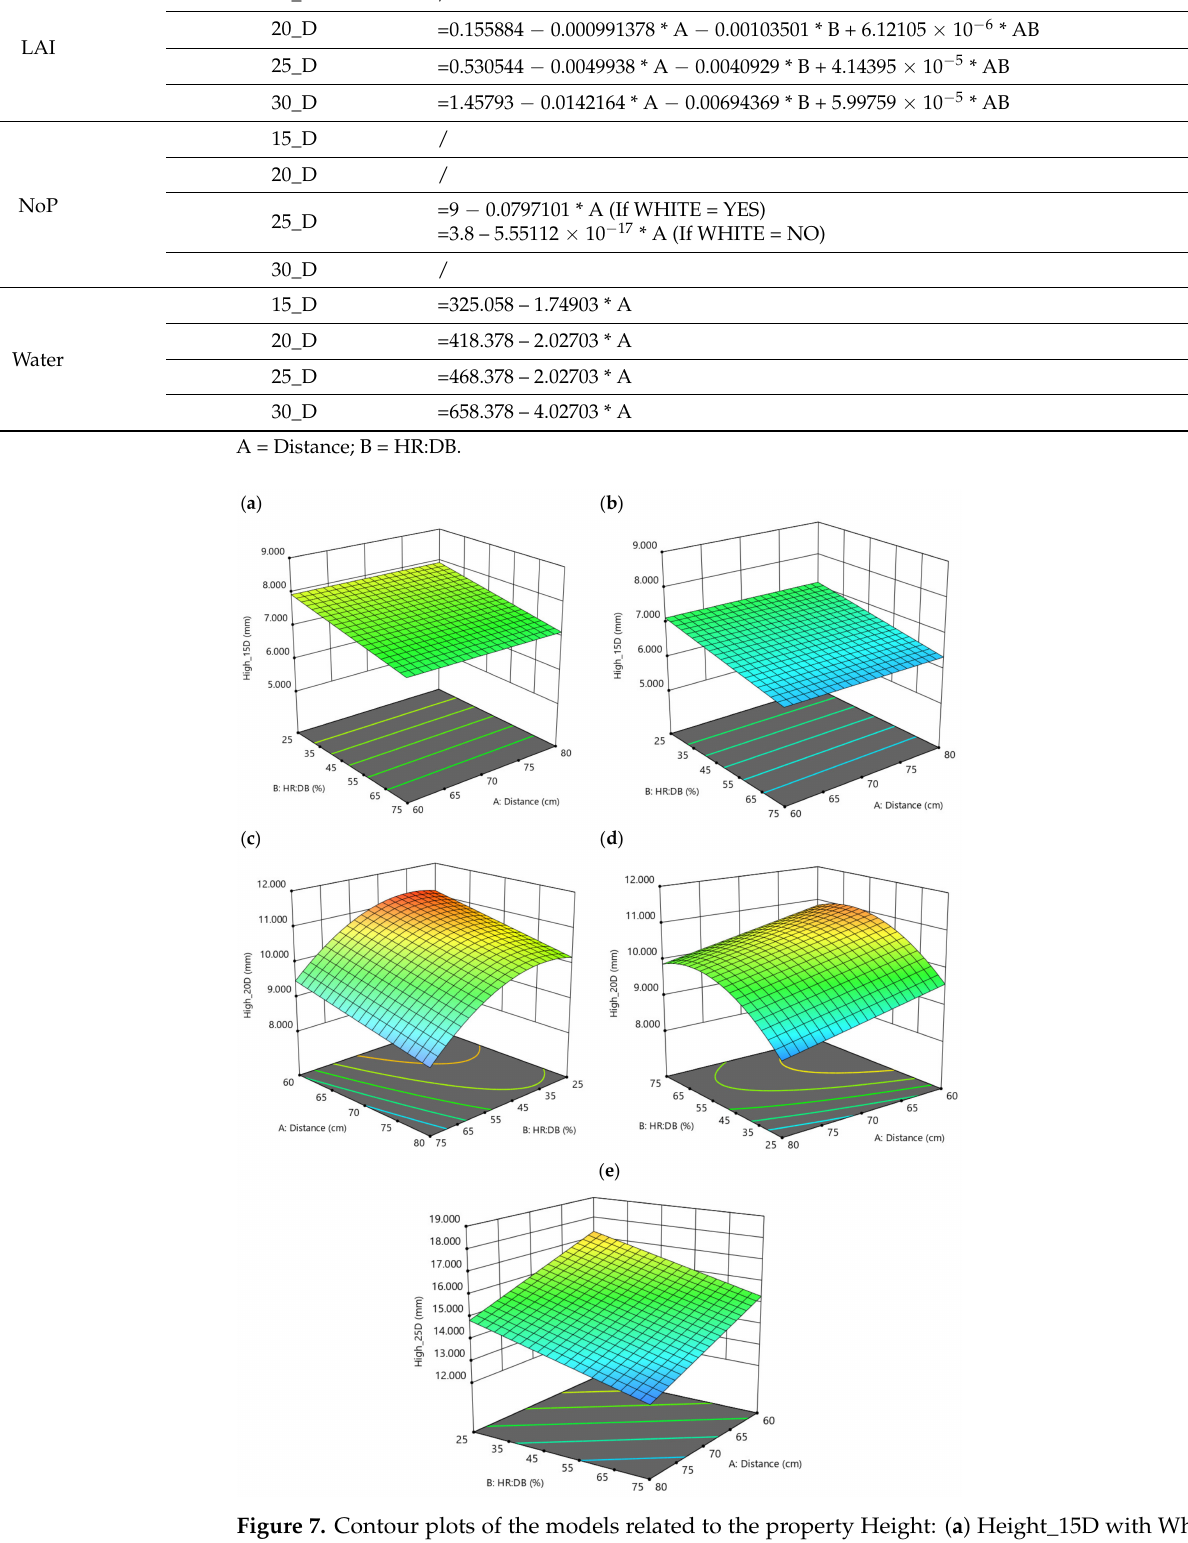
Figure 7. Contour plots of the models related to the property Height: ( a ) Height_15D with White LEDs; ( b ) Height_15D without White LEDs; ( c ) Height_20D with White LEDs; ( d ) Height_20D without White LEDs; ( e )